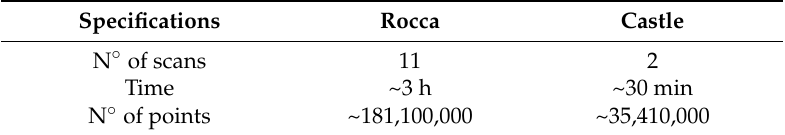
Figure 9. The ZEB survey in the Valentino Castle: ( a ) The plan view with the closed loop T2( τ ), performed, before (blue) and after (range colours) the SLAM reprocessing by merge function correction; ( b ) the attributes related to ZEB-based point cloud processing, inside the GeoSLAM Hub platform. Along with an axonometric representation of the main floor in shaded view ( I ), there are normal mapping ( II ); SLAM quality condition during the scan ( III ); time-stamp information ( IV ). Each thematic result is associated with its own trajectory data as well. Table 4. ZEB acquisition specifications.